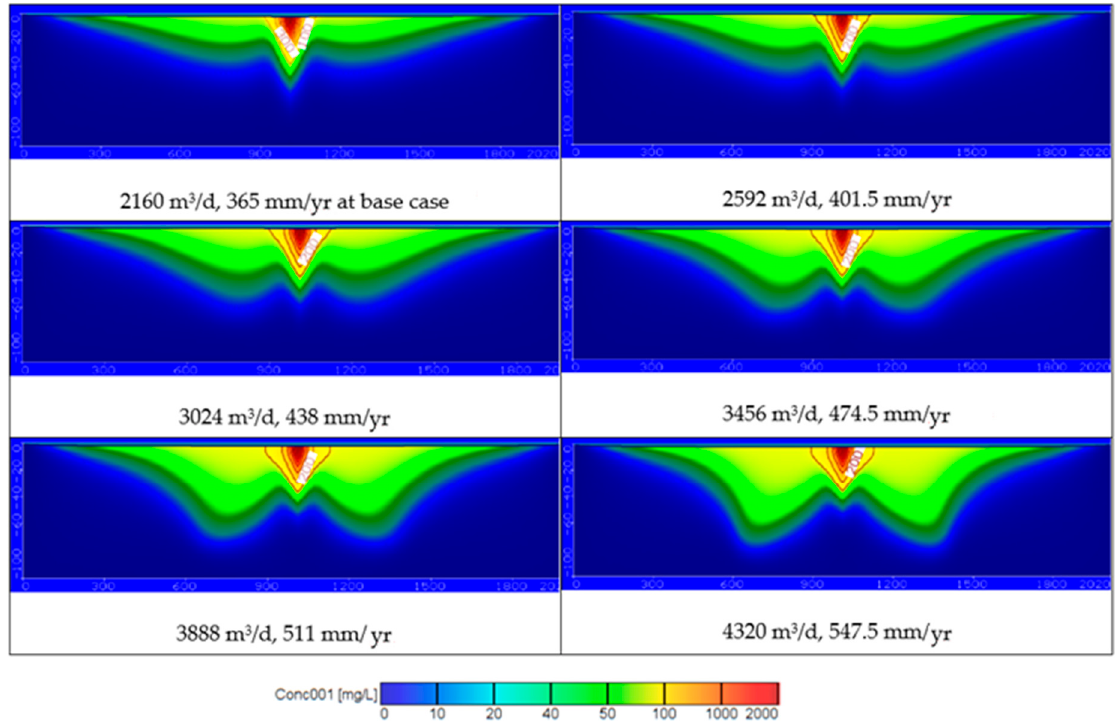
Figure 8. The distribution of COD in groundwater contamination for combination of different pumping and wastewater recharge rates.